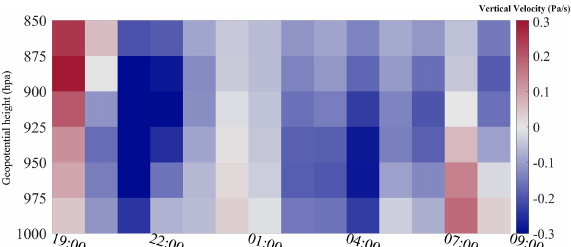
Figure 11. ERA5 hourly vertical velocity from 19:00LT on 17 September 2019 to 09:00LT on 18 September 2019, at 23.25 ◦ N, 113.25 ◦ E. Negative values indicate upward motion.